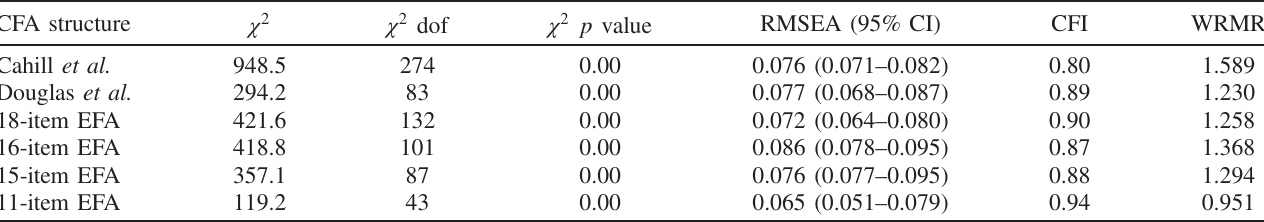
TABLE IX. Comparison of global fit indices across models.